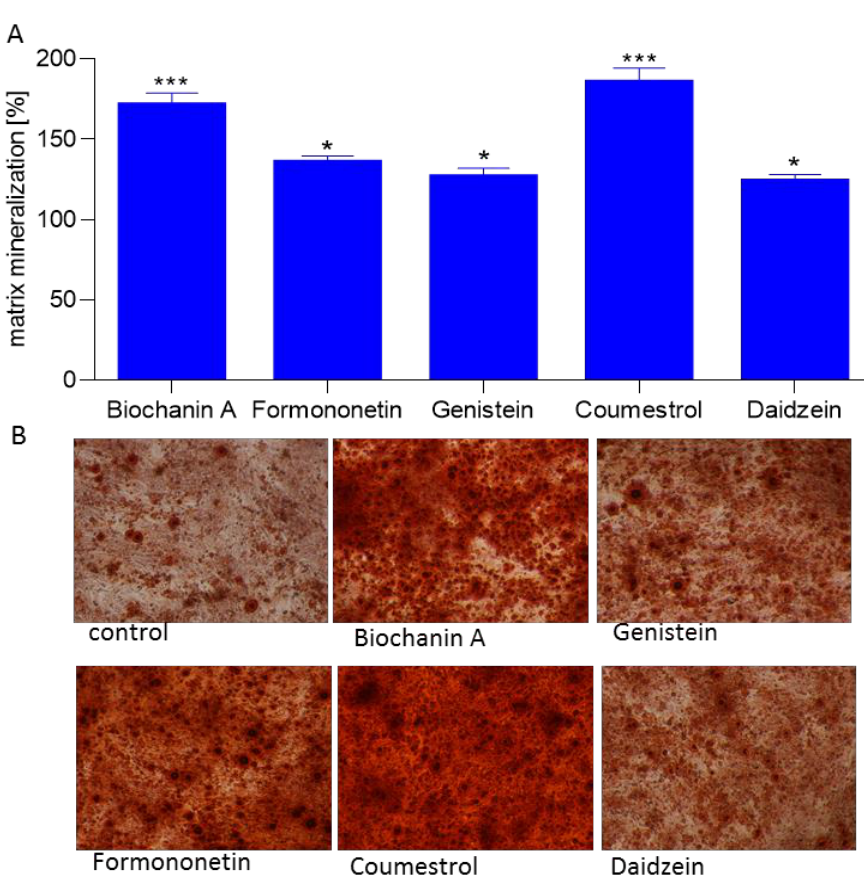
Figure 7. The influence of isoflavones on Saos-2 cells matrix mineralization determined by Alizarin Red S spectrophotometric assay after 14 days exposure. Control cells were not exposed to any compound but the vehicle; values are means ± standard deviations from at least three independent experiments ( n ≥ 9) statistical significance was calculated versus control cells (untreated), * p ≥ 0.05, ** p ≥ 0.01, *** p ≥ 0.001 ( A ); representative images of cells stained with Alizarin Red S after treatment with isoflavones using Nikon TS100 Eclipse microscope (Japan), 200× magnification ( B ).